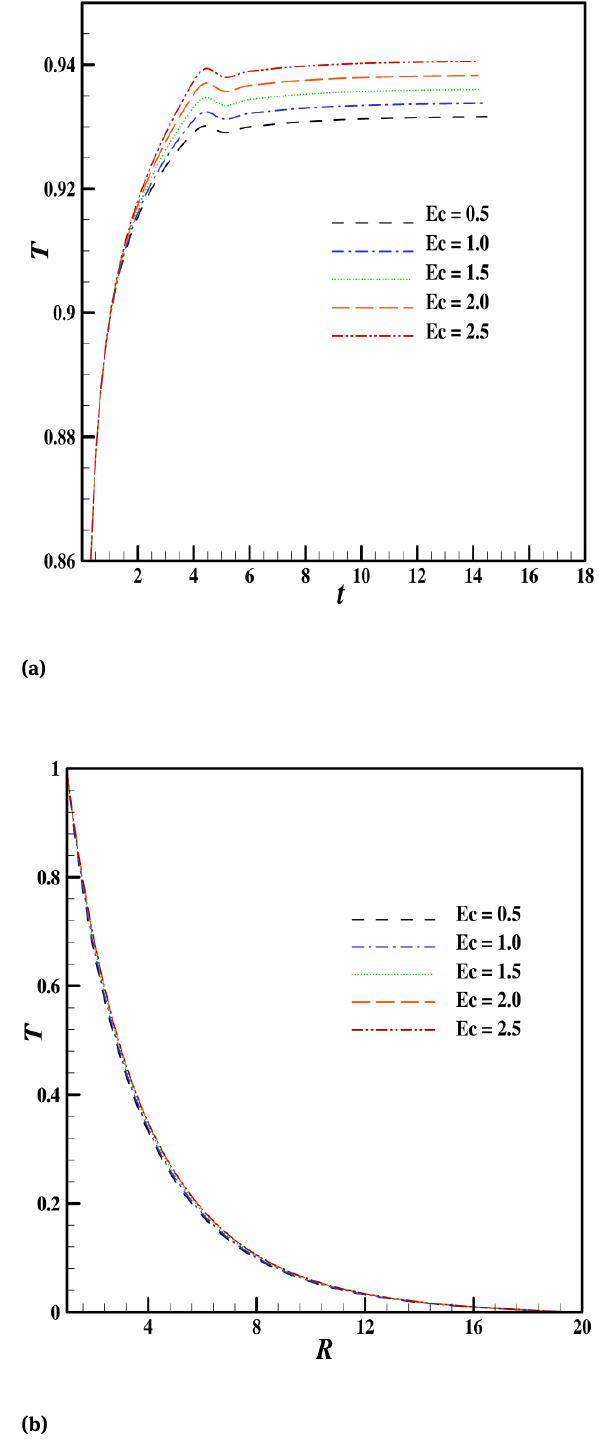
Figure 14: ( a ) Transient and ( b ) Steady state temperature profiles with fixed Sc = 0.6 , Pr = 0.7 , Kr = −0.2 , Bu = 1.0 , Nr = 1.0 , K 1 = 1.0 , M = 0.2